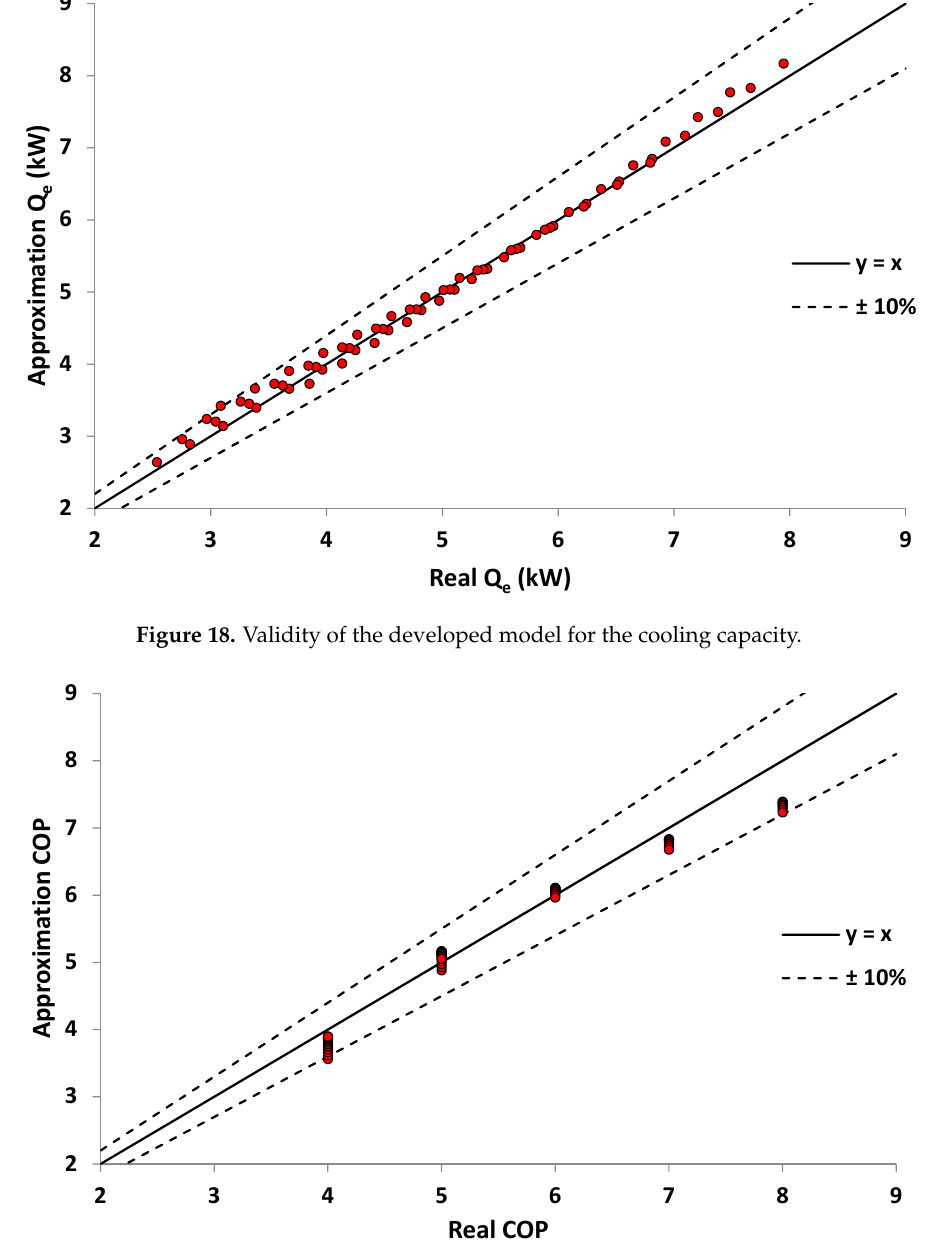
Figure 19. Validity of the developed model for the COP.